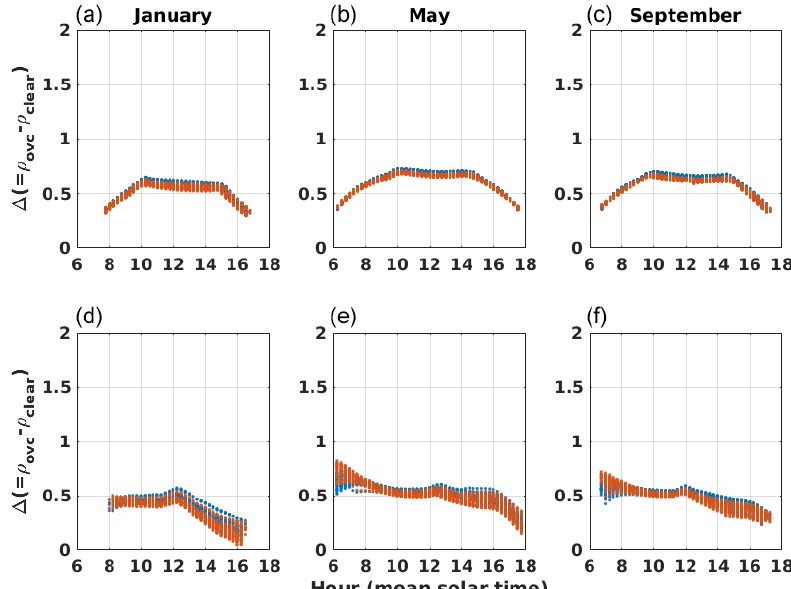
Figure B5. Difference between simulated reflectances at the top of the atmosphere in overcast and clear-sky conditions (cid:49) = ρ ovc − ρ clear for the Tamanrasset (Algeria, a–c ) and Sede Boker (Israel, d–f ) locations and for the January, May, and September calendar months (a, d ; b, e ; c, f) . In blue dots: MSG 0.6µm channel; in red dots: MSG 0.8µm channel.